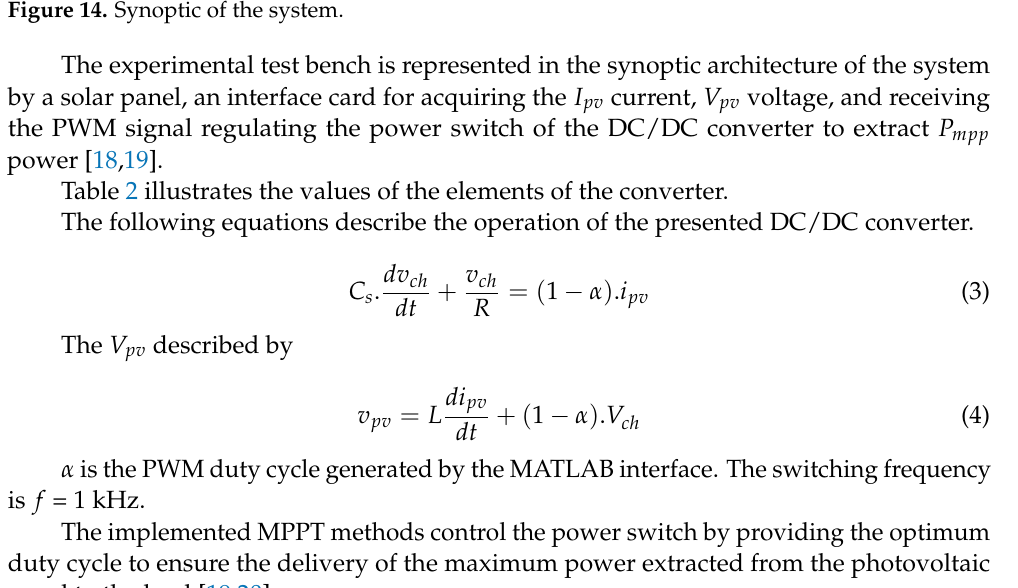
Figure 14. Synoptic of the system.